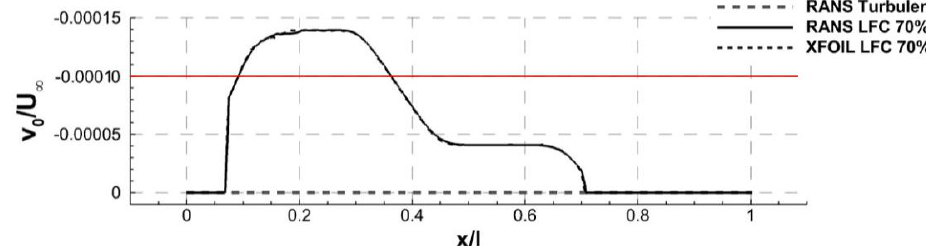
Figure 8. Fuselage suction profile at Mach = 0.8. Adapted from [19]. The red line represents the selected conservative value for the